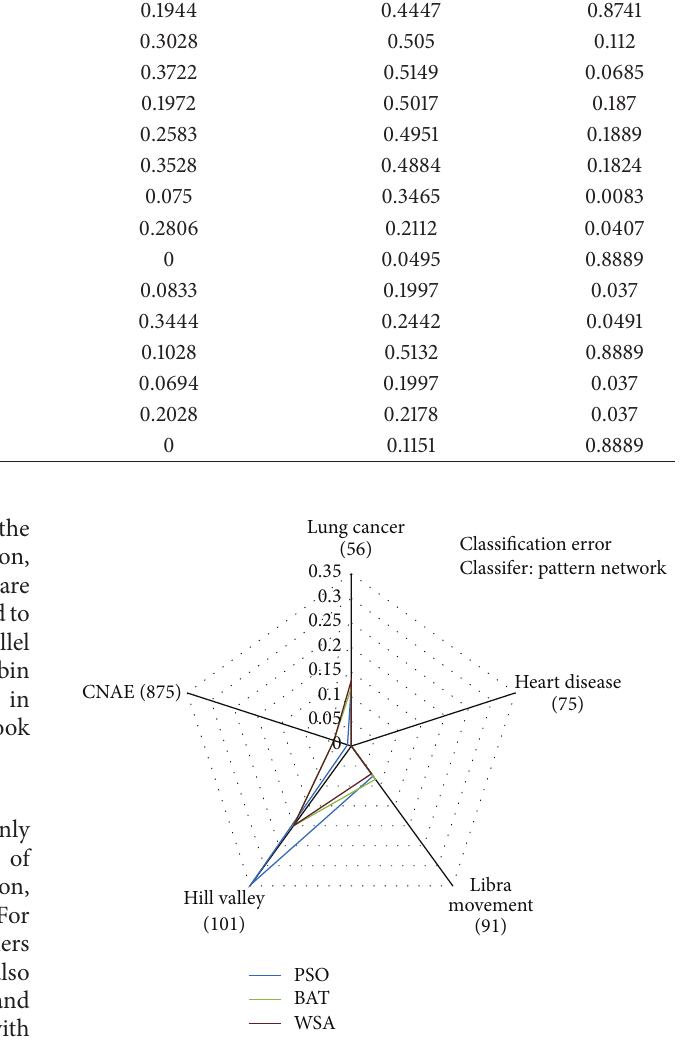
Figure 4: Results in classification error for Pattern Network are shown visually in radar